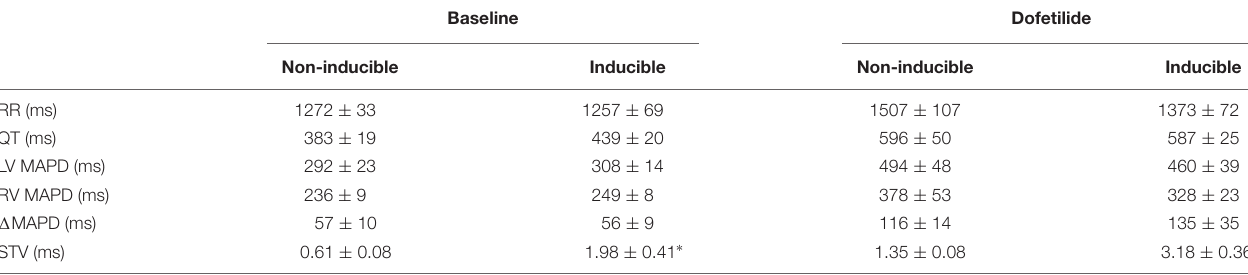
TABLE 3 | Electrophysiological parameters of non-inducible and inducible dogs.